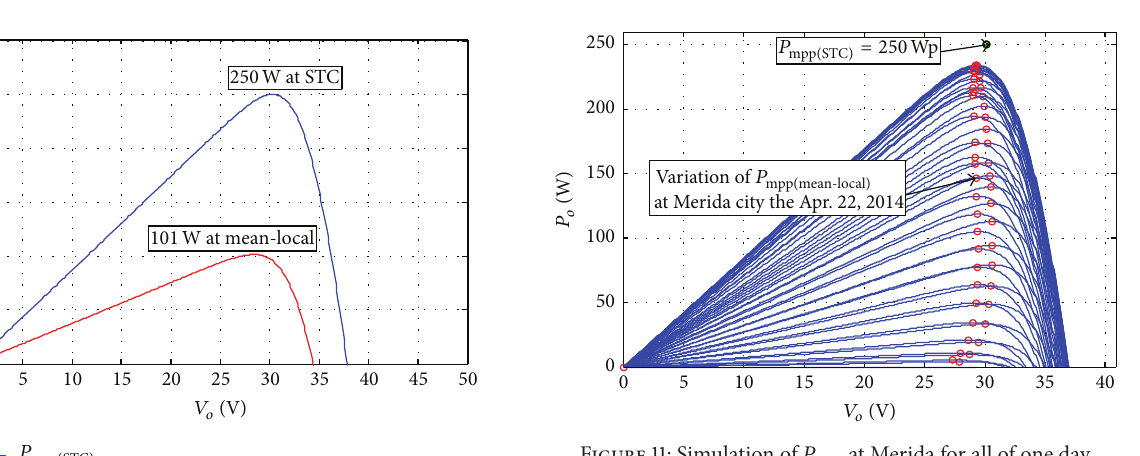
respect STC values. P-N